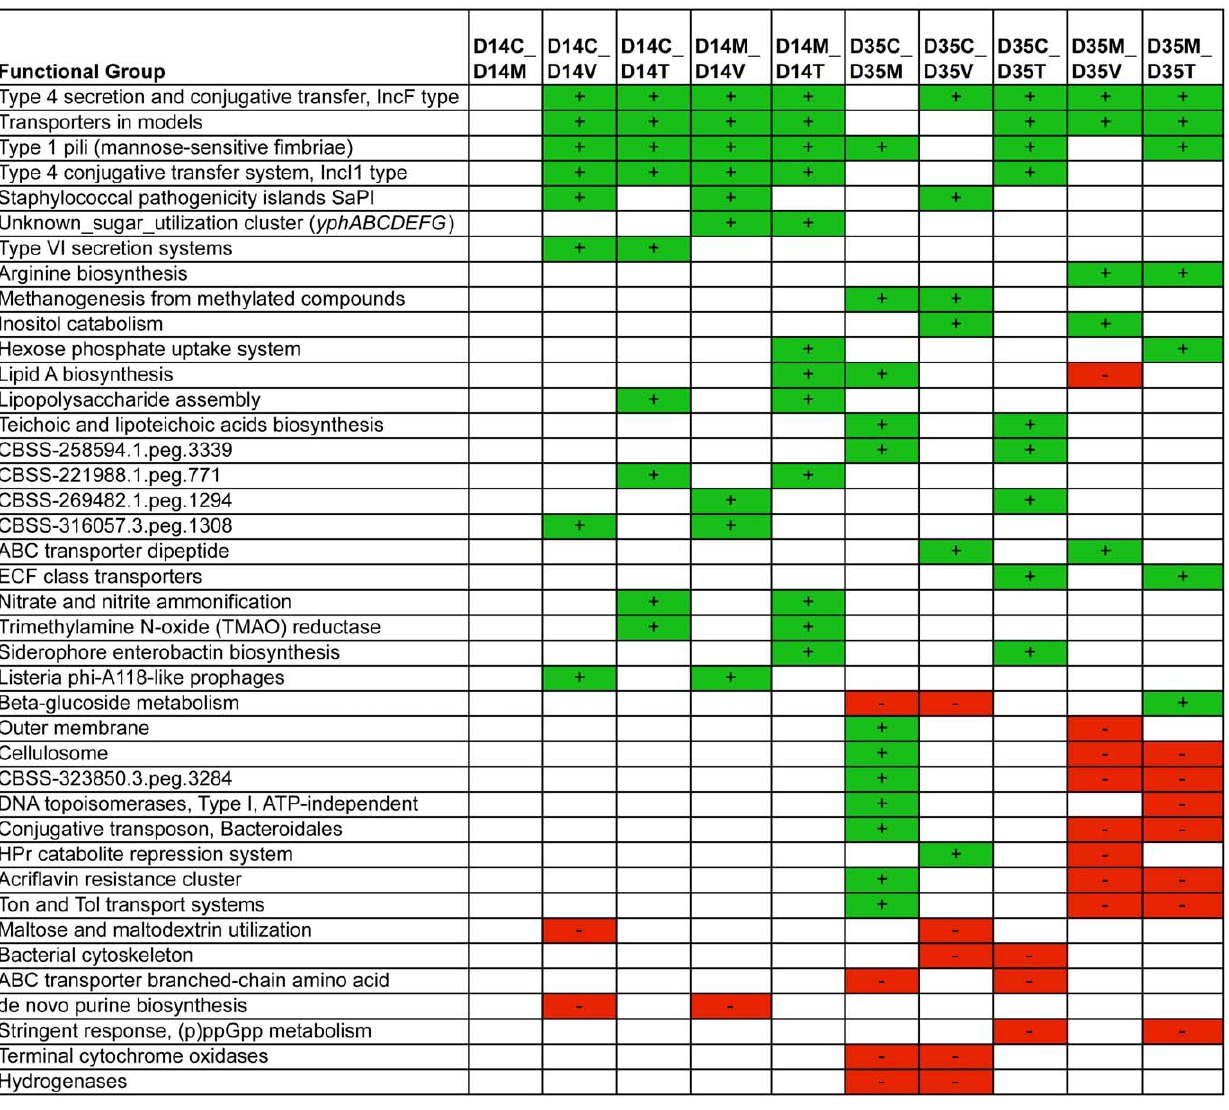
Figure 9. Comparison of functional group distribution identified via shotgun metagenomic sequencing at timepoints D14 and D35. Only groups with multiple significant shifts (p , 0.05) are shown, from a total of 773 functional subsystems. Functional groups that were significantly enriched (green) or depleted (red) compared to the control group for that timepoint are shown (p , 0.05). For each timepoint (D0, D7, D14, and D35), C = control diet, M = monensin treatment, V = monensin/virginiamycin treatment, and T = monensin/tylosin